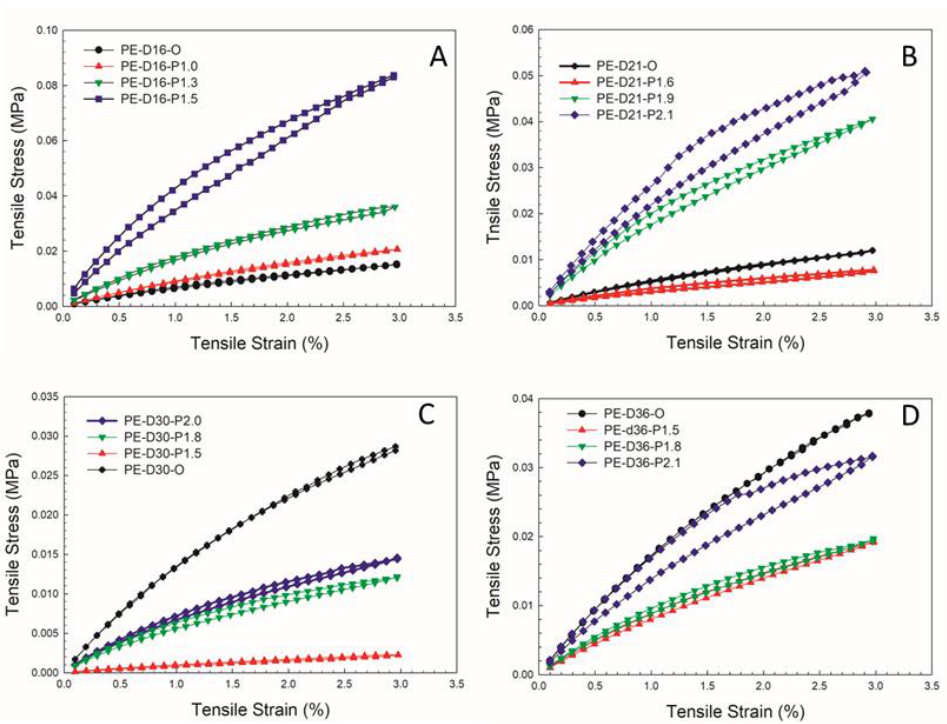
Figure 8. Tensile hysteresis loops of the auxetic and original foams based on ( A ) D16, ( B ) D21, ( C ) D30 and ( D ) D36.